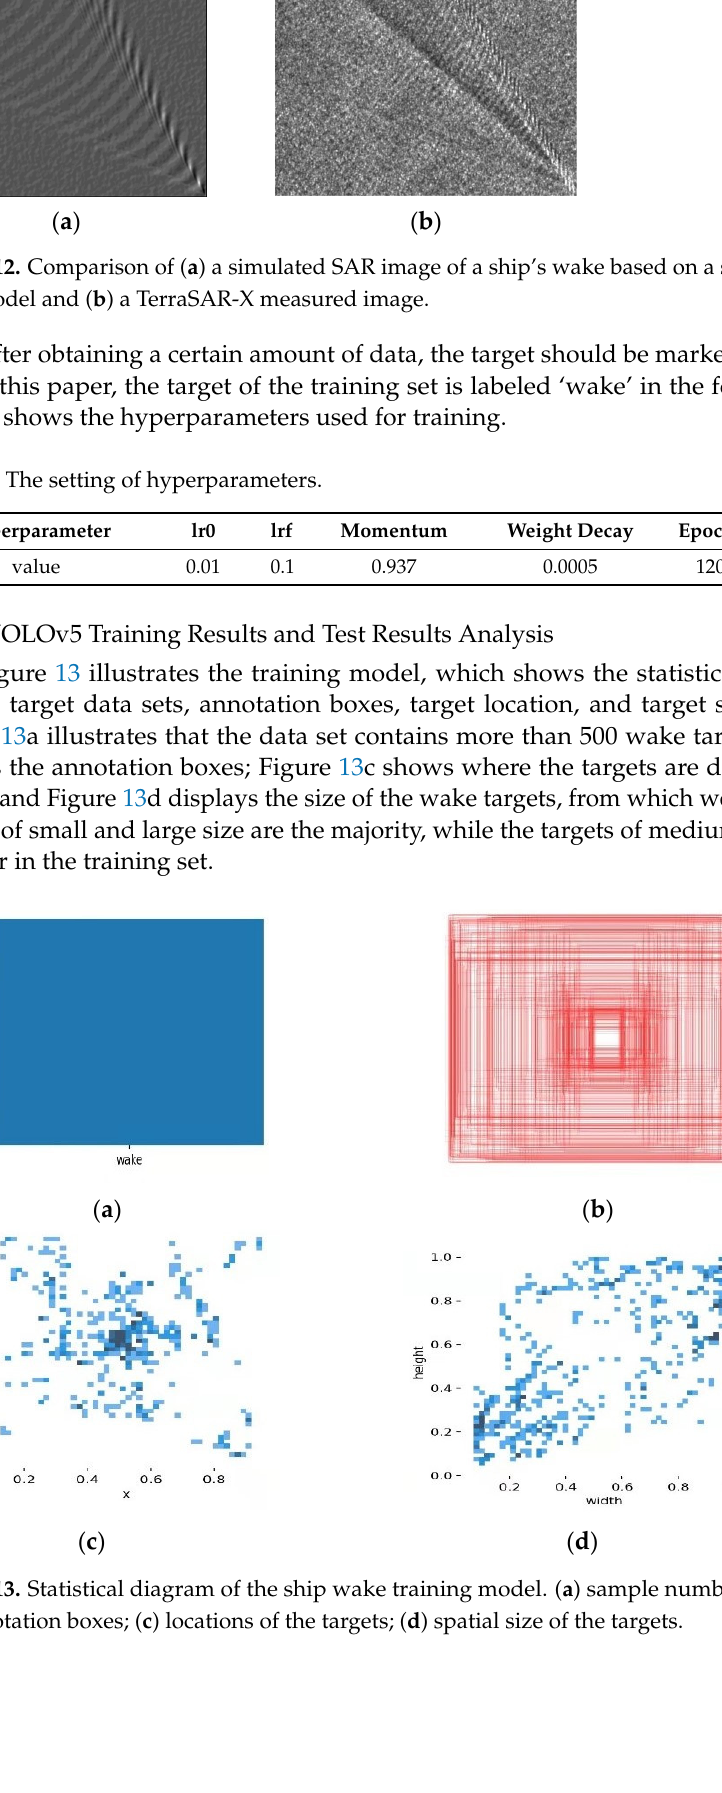
( b ) Figure 14. P-R Curve of a simulated SAR Image as test set: ( a ) P-R curves in different sea states (Low sea state: red line; High sea state: blue dot line); ( b ) P-R curves under different network structures. Among the YOLOv5’s detection network, the YOLOv5s and YOLOv5l are chosen to be compared in Table 4. The former has the smallest depth and width, while the latter has larger ones. YOLOv5s has a network depth of 0.33 and a network width of 0.50. YOLOv5l has a network depth of 1.0 and a network width of 1.0. As shown in Figure 14b, with the increased depth and width, the detection accuracy has improved. On the contrary, in ac- tual detection, the detection speed of YOLOv5s is only tens of milliseconds. The detection time of YOLOv5l is several times that of YOLOv5s, and under the same epoch and batch conditions, the training time is also increased by more than three times.